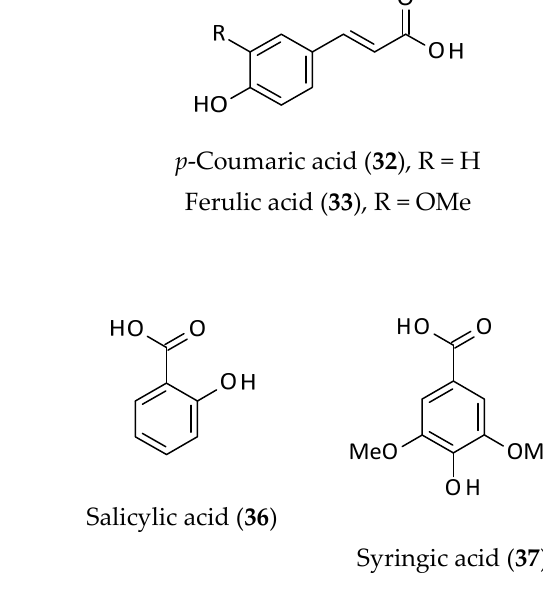
Figure 6. Other phenolics from Alternanthera philoxeroides.